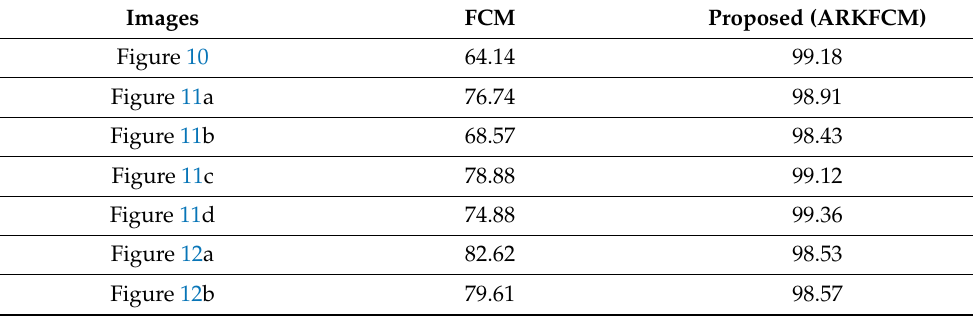
Table 6. Jaccard index with FCM and Proposed ARKFCM method.